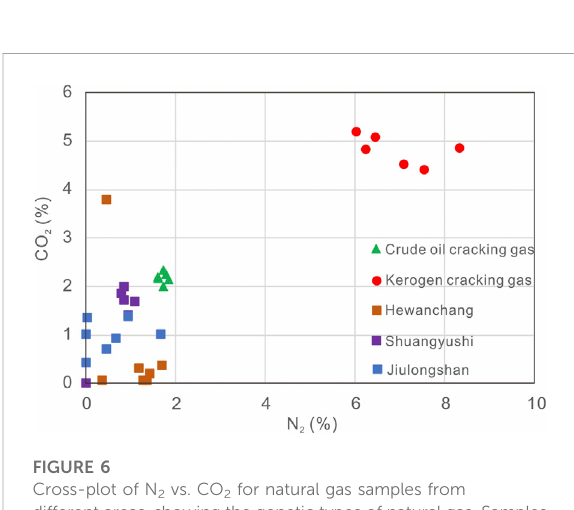
FIGURE 6 Cross-plot of N 2 vs. CO 2 for natural gas samples from different areas, showing the genetic types of natural gas. Samples of crude oil cracking gas and kerogen cracking gas are according to Li et al. (2019) and Yin et al. (2001),